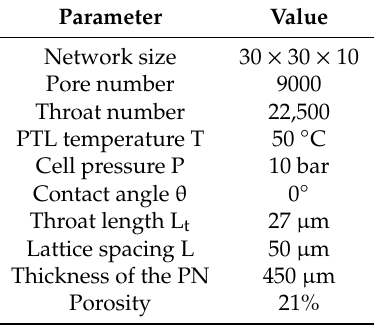
Table 1. Simulation